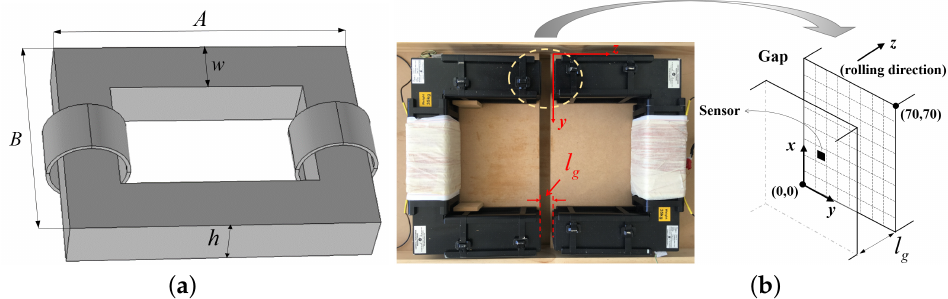
Figure 1. ( a ) The configuration of the two-phase two-limb transformer; ( b ) Photo of the two U-shaped cores to form the transformer and details of the air gap region.